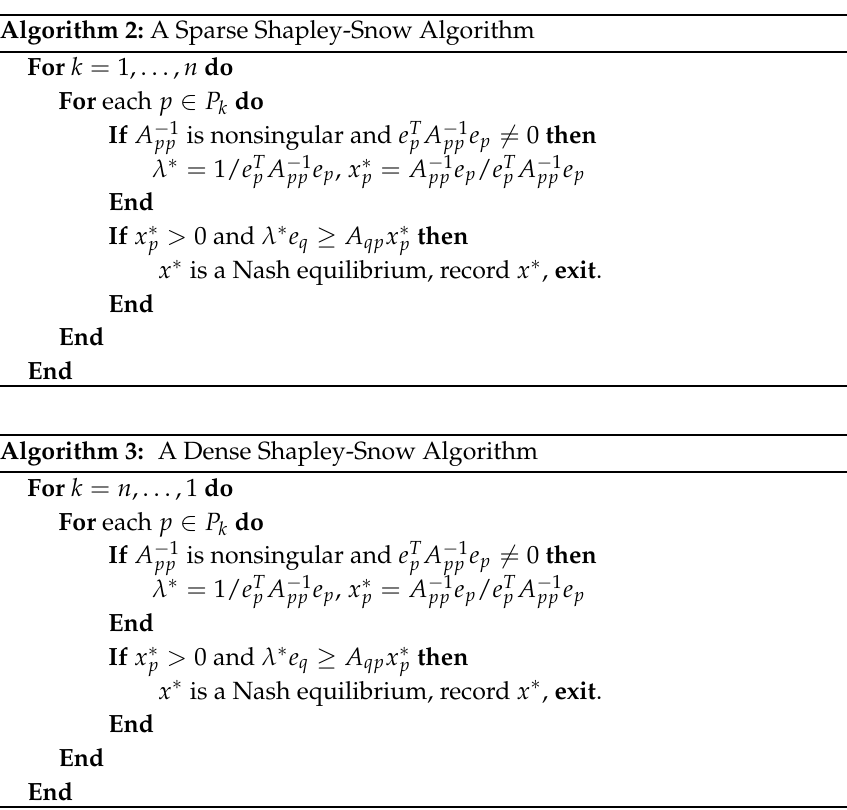
Algorithm 2: A Sparse Shapley-Snow Algorithm For k = 1, . . . , n do